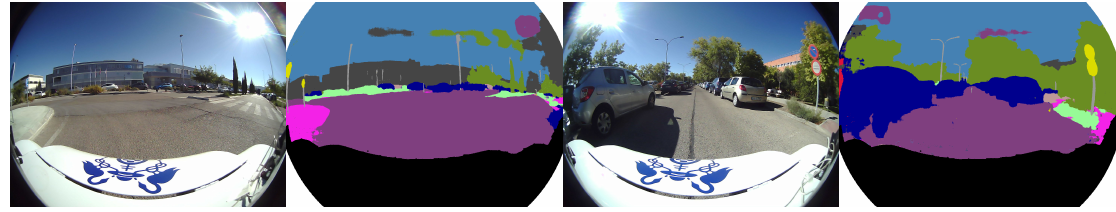
Figure 18. Problems with sky segmentation and